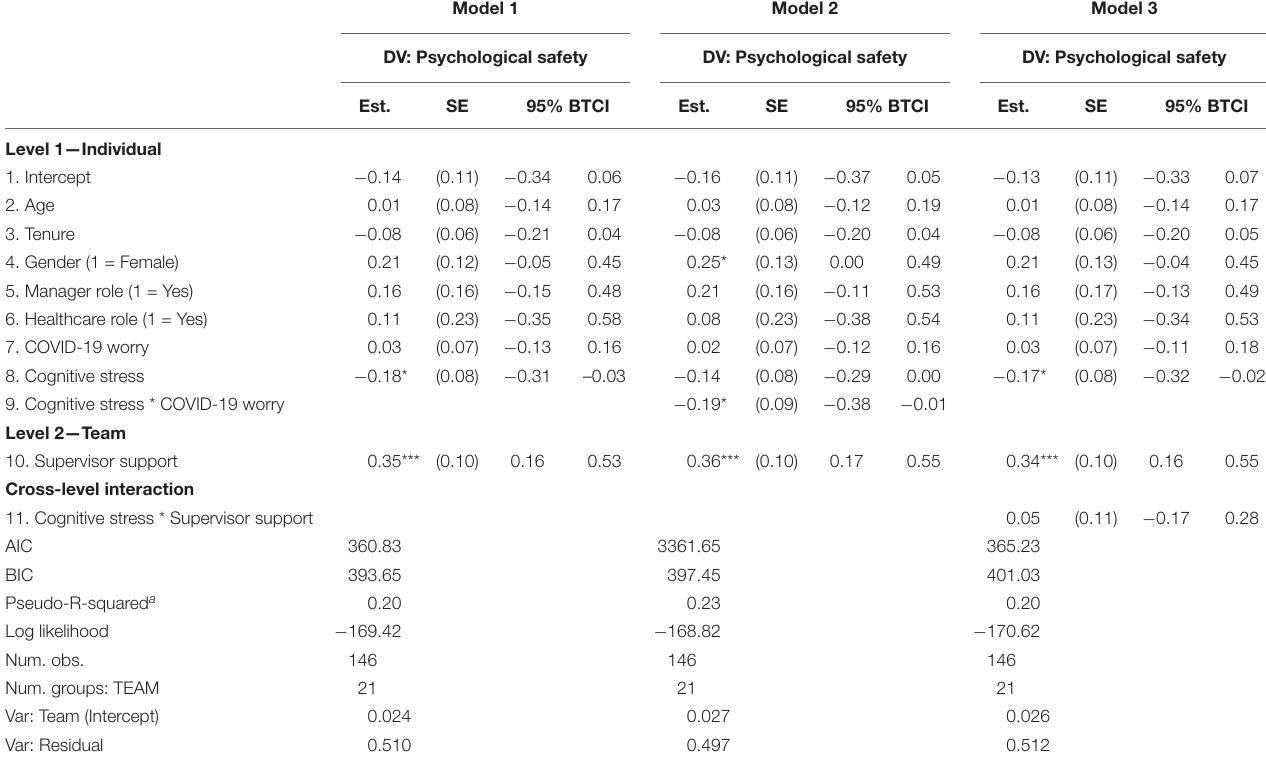
TABLE 4 | Multilevel moderation analysis random-intercept-only model.